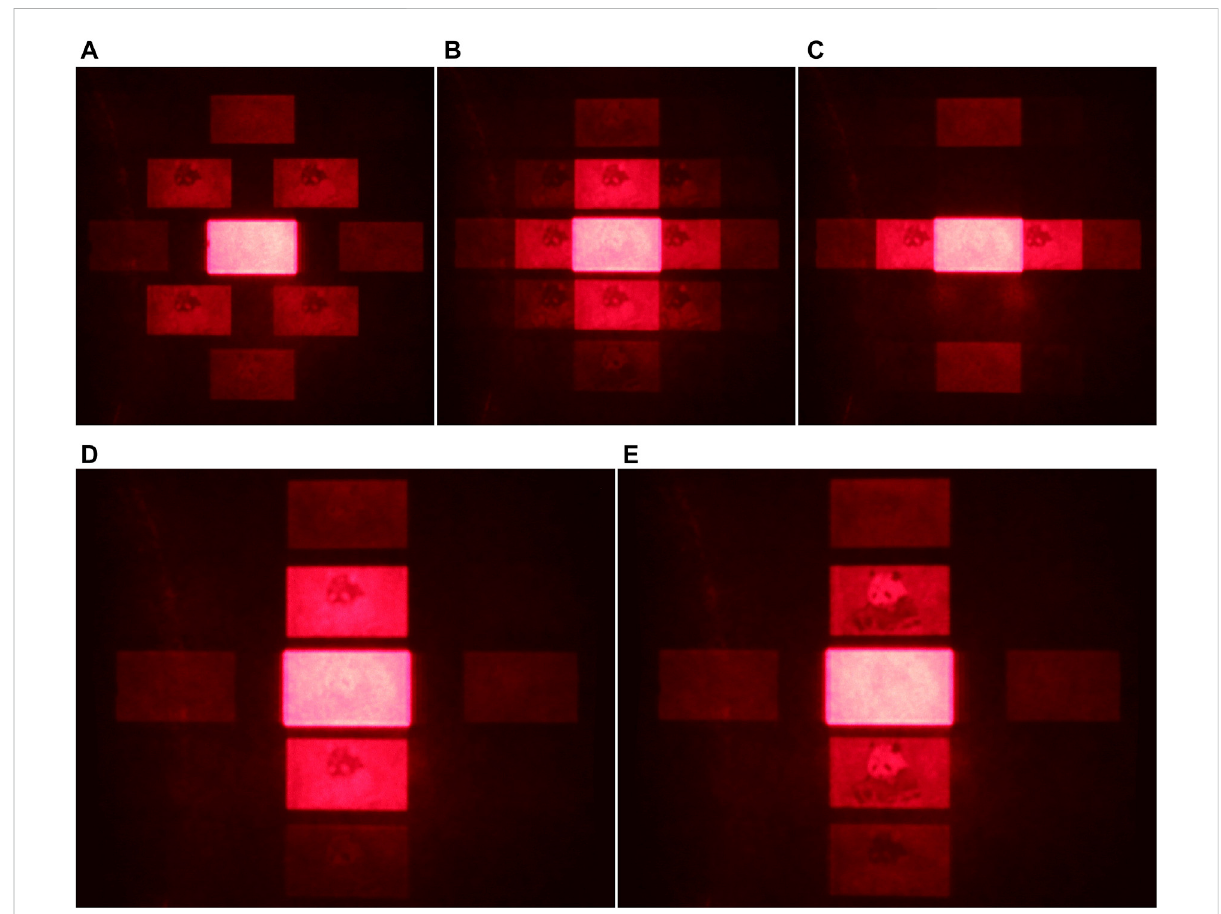
FIGURE 12 Optical diffraction patterns of phase-only holograms with different encoding methods. (A) Checkerboard-like encoding method, (B) grid-like encoding method, (C) strip-like encoding method in x -axis direction, (D) strip-like encoding method in y -axis direction, and (E) the proposed method. The diffraction distance is 120 mm, and the physical size of the reconstruction is 8.08 mm × 14.36